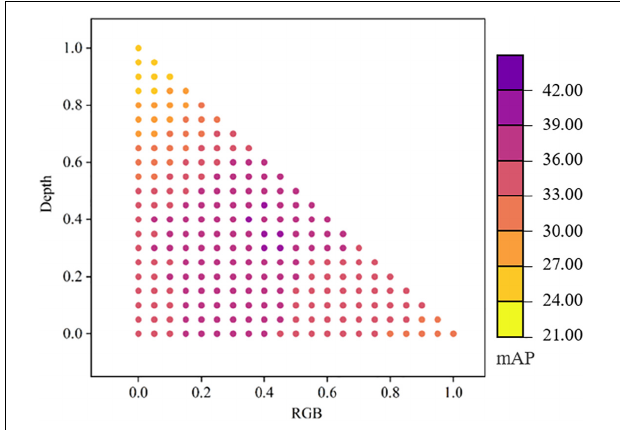
FIGURE 7 | Ensemble learning results of RGB-specific, depth-specific, and RGB-D-correlated models with different weight